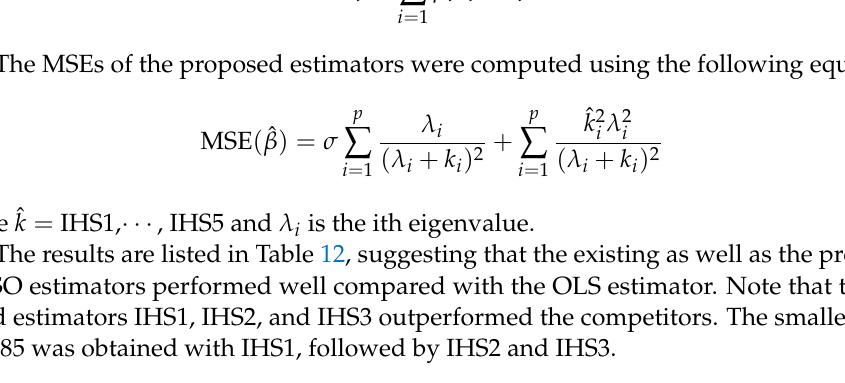
Table 10. Descriptive statistics for cruise-ship-info data.